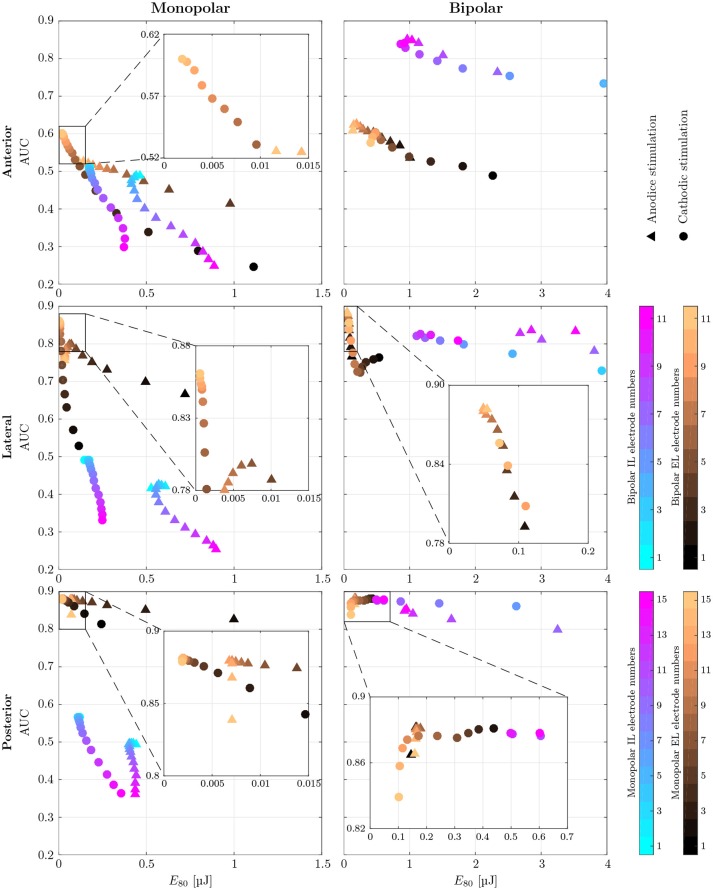
AUC values of monopolar (Left) and bipolar (Right) stimulation with IL and EL, cylindrical electrodes (color-coded) using anodic (triangles) and cathodic (circles), pseudomonophasic pulses plotted against the stimulus energy E80 required for 80 % target nerve activation. Targeted were the anterior (top row), the lateral (central row) and the posterior (bottom row) ampullary nerves. The color-coded electrode numbers refer to the labels depicted in Figures 4C,D. Bipolar electrode numbers refer to the current source. The current sink was chosen as described in section 2.4. Regions of interest with high AUC values and low energy consumption are presented in a detailed view. EL electrode configurations show reduced energy expenditure compared to IL configurations throughout all simulations. Also, higher AUC values are achieved by EL electrodes in all but the anterior bipolar stimulation approach.